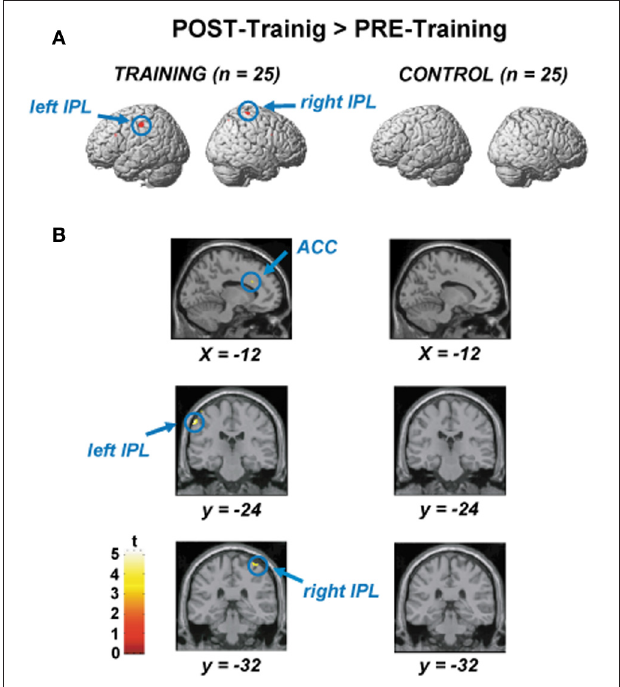
FIGURE 3 | (A) Areas of significantly increased activation after the training, as determined by paired t- test between the pre- and post-training session. The figures on the left side show activations for the training participants, and those on the right show those for the control participants. (B) Significant ACC activation (upper), left IPL activation (middle), and right IPL activation (lower) by paired t -test between the pre- and post-training